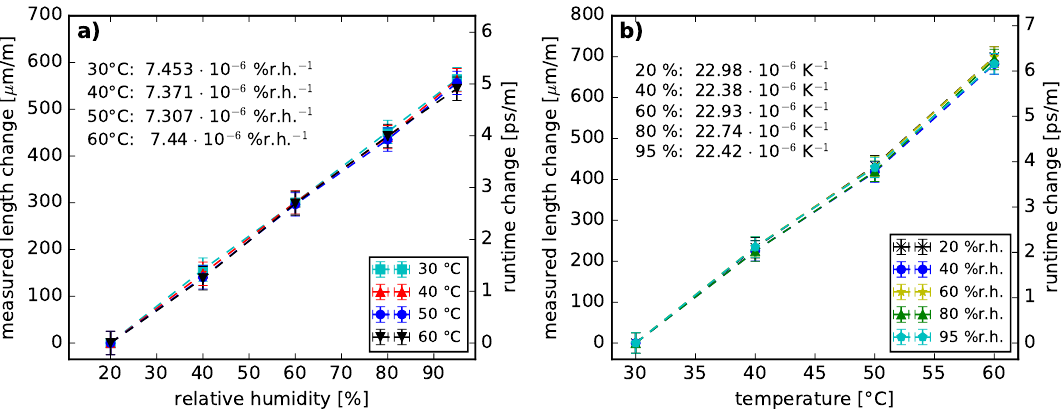
Figure 3. Measured relative fiber length change and optical runtime changes induced by ( a ) humidity as well as ( b ) temperature. The displayed coefficients are the slopes of the linear regression functions computed for all temperature or humidity values based on the measured fiber length